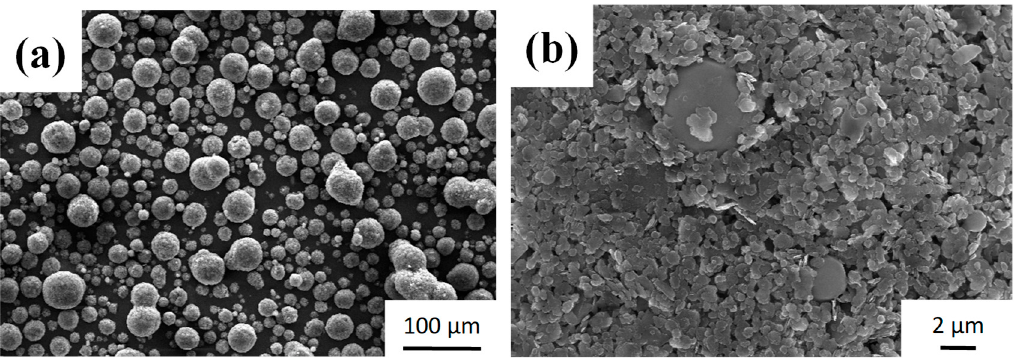
Figure 2. ( a ) Powder morphology and ( b ) cross-sectional view of DP25B75 powder.